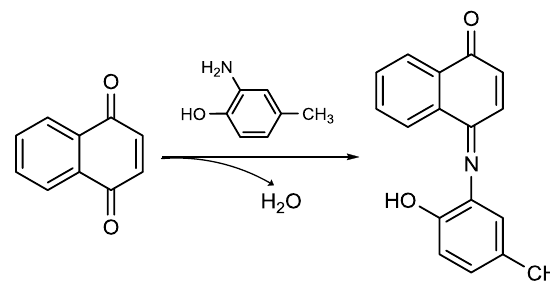
Figure 1: Synthesis reaction of PINQ molecule.